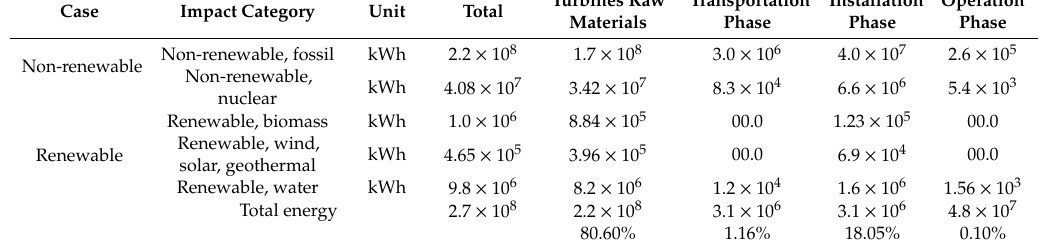
Table 14. The cumulative energy demand (38 turbines) of each phase for each type of energy for a 20- year lifespan.